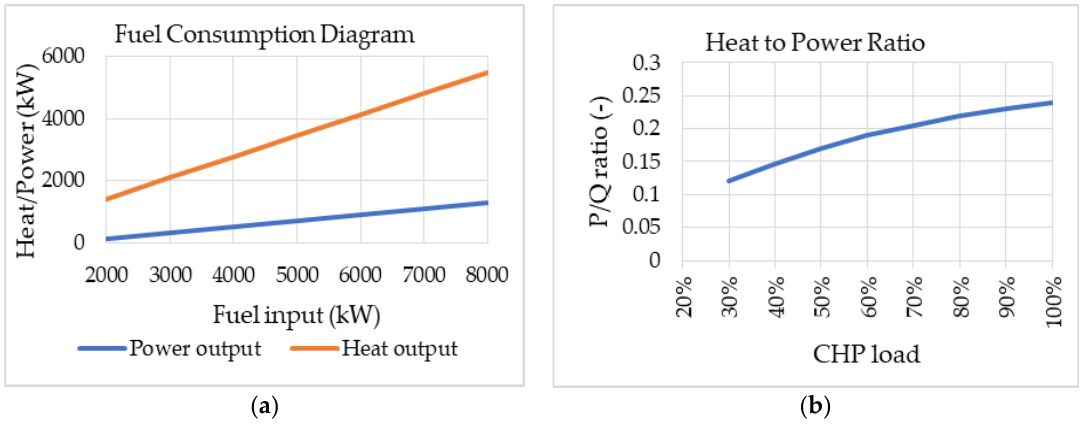
Figure 6. Regime diagrams of the CHP unit: ( a ) Fuel consumption diagram; ( b ) Heat to power ratio.